Question: Express in one sentence what the figure is showing.
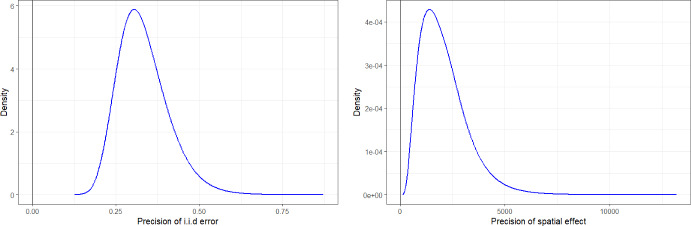
Answer: Density plot of the precision of i.i.d. error ( \documentclass[12pt]{minimal} \usepackage{amsmath} \usepackage{wasysym} \usepackage{amsfonts} \usepackage{amssymb} \usepackage{amsbsy} \usepackage{mathrsfs} \usepackage{upgreek} \setlength{\oddsidemargin}{-69pt} \begin{document}$$1/\sigma ^2$$\end{document} 1 / σ 2 ) (left panel), and precision of spatial random effect ( \documentclass[12pt]{minimal} \usepackage{amsmath} \usepackage{wasysym} \usepackage{amsfonts} \usepackage{amssymb} \usepackage{amsbsy} \usepackage{mathrsfs} \usepackage{upgreek} \setlength{\oddsidemargin}{-69pt} \begin{document}$$1/\tau ^2$$\end{document} 1 / τ 2 )